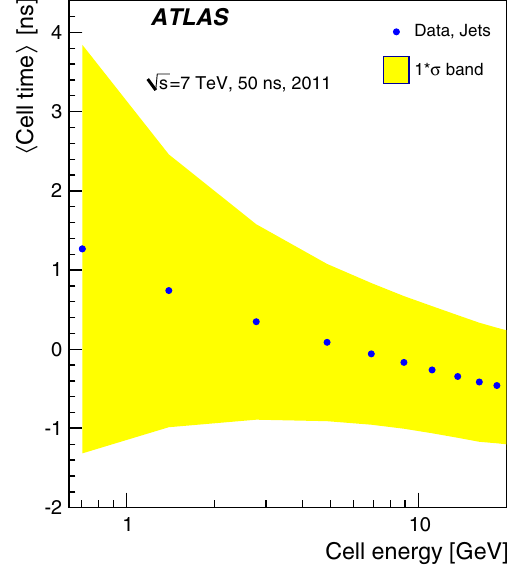
Fig. 5 Left: the mean cell reconstructed time (average of the times in the two channels associated with the given cell) as measured with jet events. The mean cell time decreases with the increase of the cell energy due to the reduction of the energy fraction of the slow hadronic